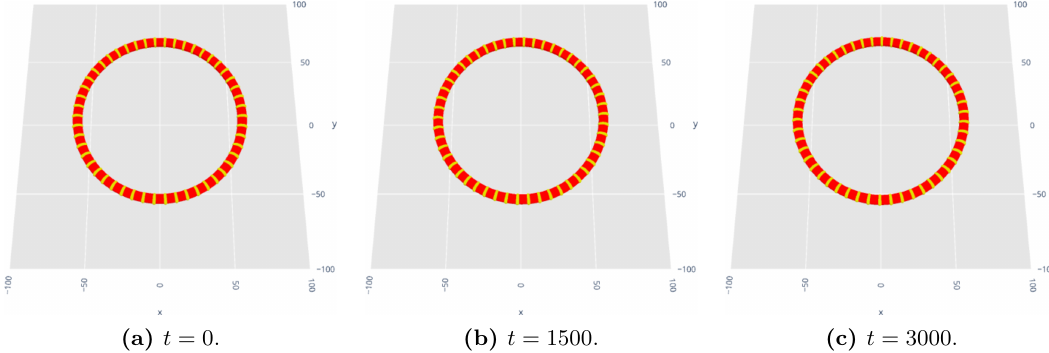
Figure 19 . Isosurfaces of a vorton with Q = 1594 and N = 50 in the parameter set η σ = 0 . 61 , λ σ = 10 , β = 3 and G = 0 . 5 (parameter set B). | φ | = 3 in yellow. There are no signs of any instabilities, but this does not yet indicate that the vorton is completely stable — only that the modes it could be unstable to are not excited in this simulation, or that the growth rate is small enough so that the instability has not significantly grown by the end of the simulation.